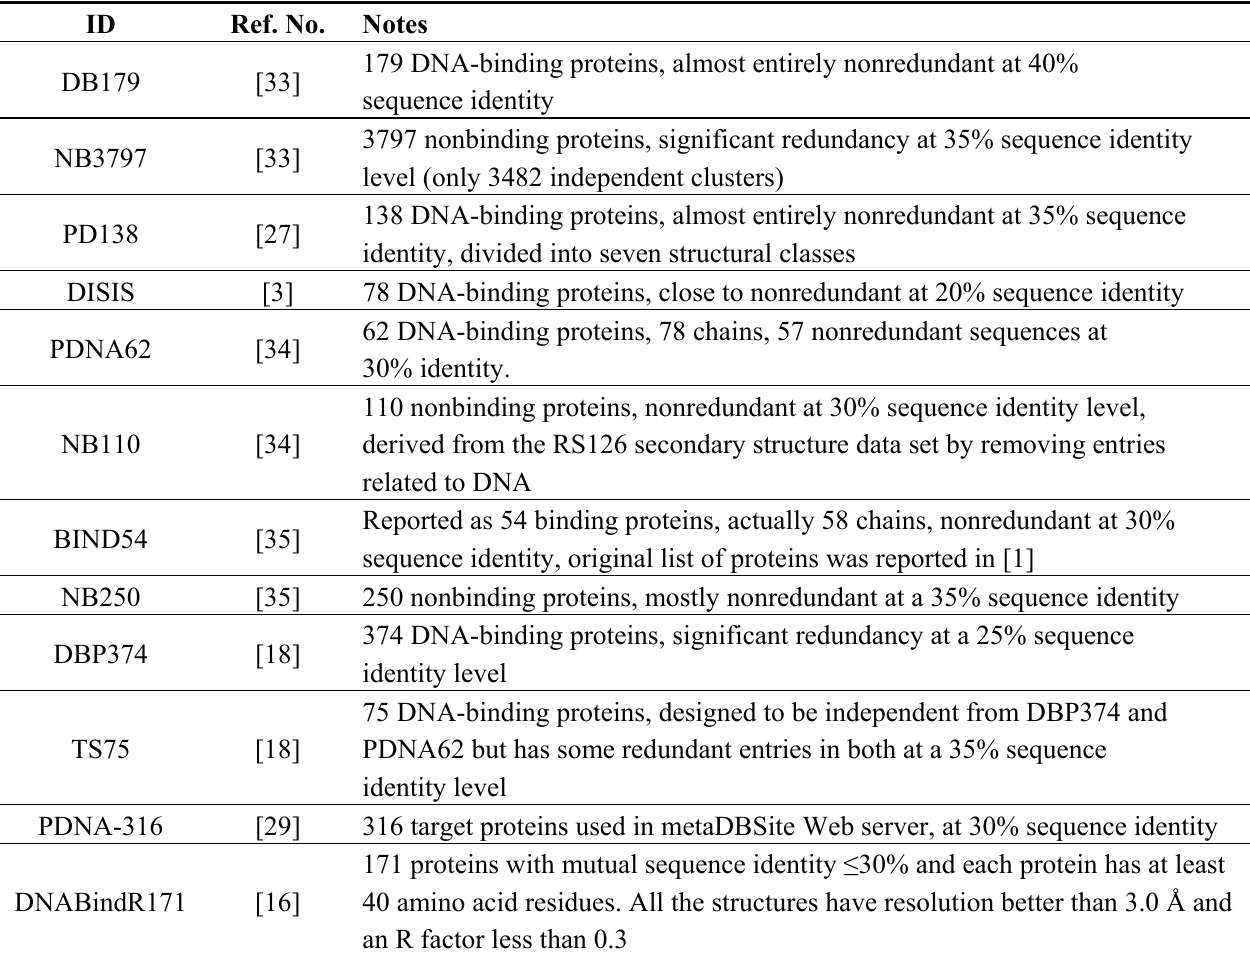
Table 1. Commonly used data sets for DNA-binding site